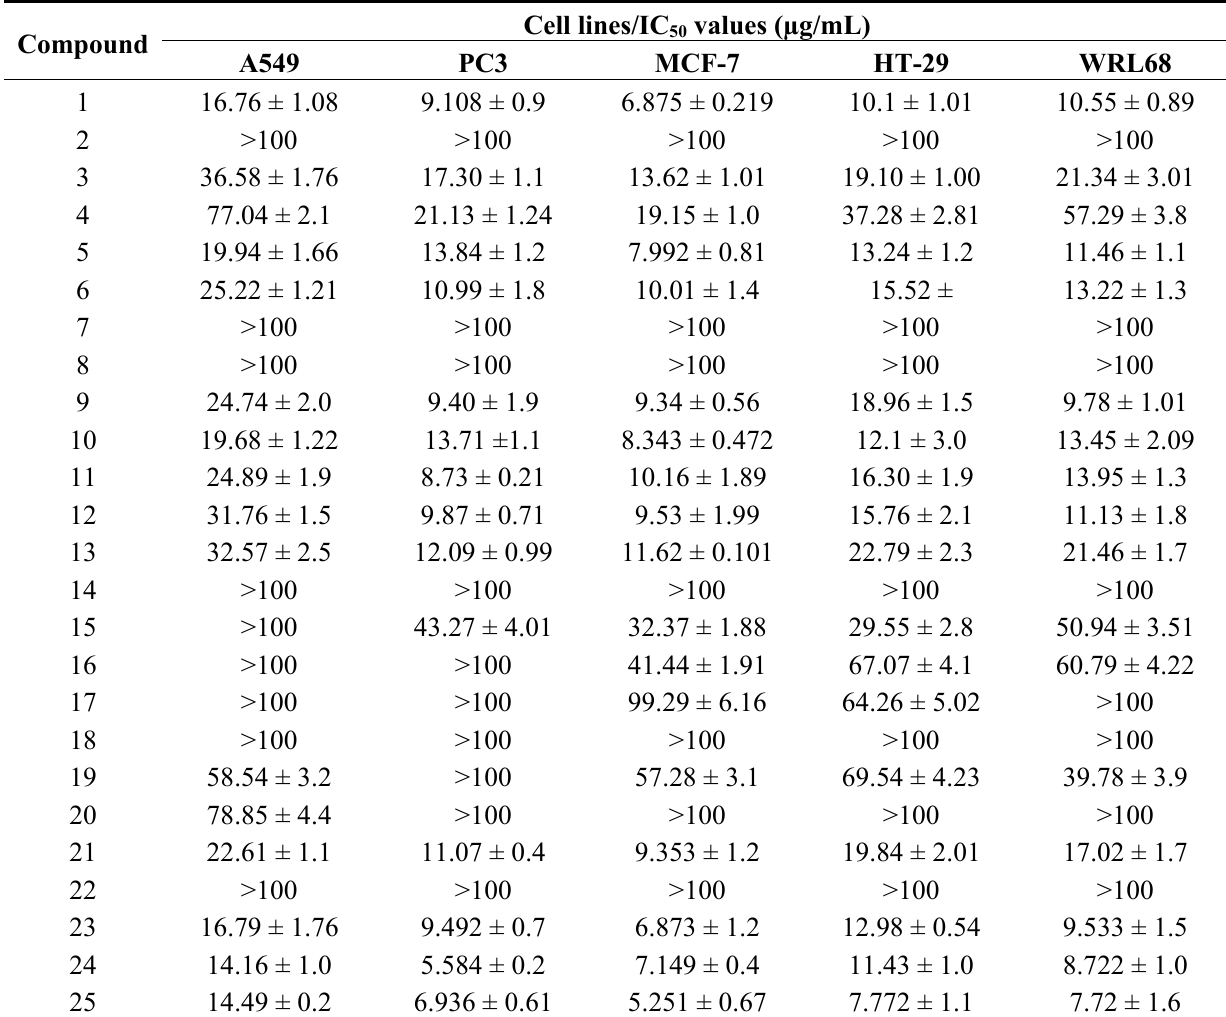
Table 3. Cytotoxicity of compounds on different cell